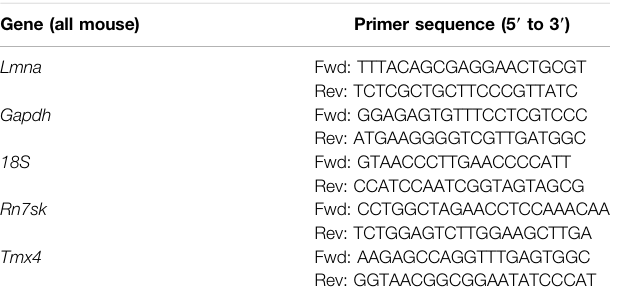
TABLE 2 | Temperature and cycle settings for Real-Time PCR. Step